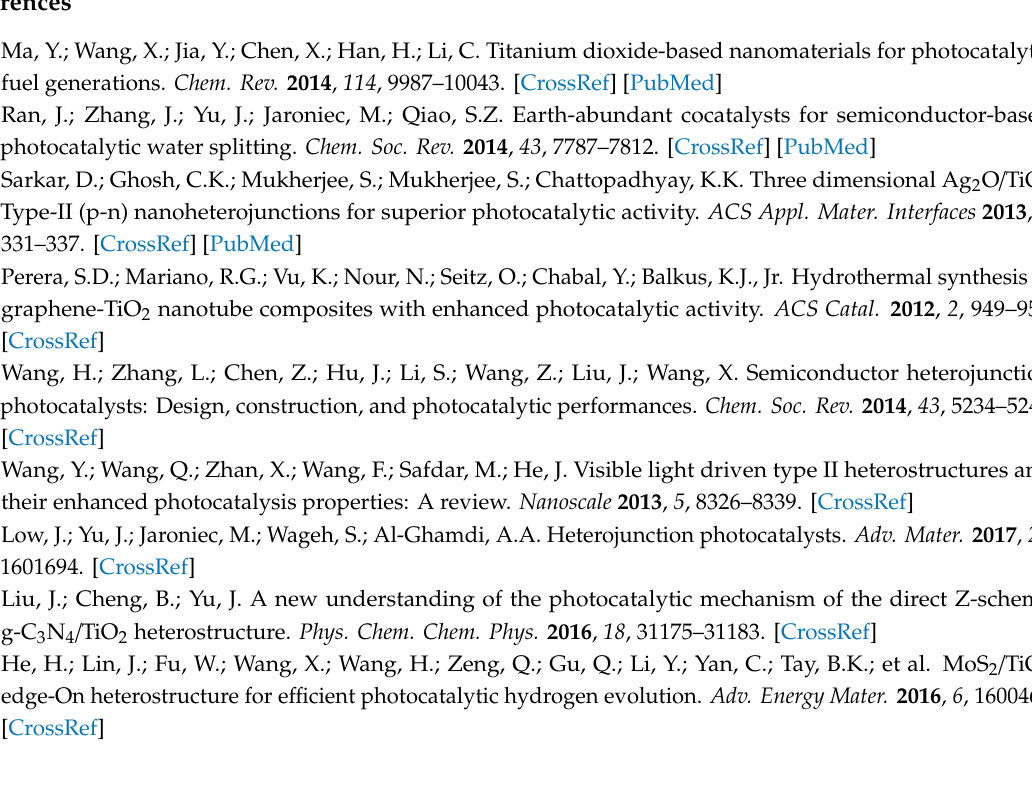
Figure S1 (a-d) EDS spectra of TA1, TA2, TA4, and TA8 samples, respectively. Figure S2 (a-f) XPS survey spectra of T, A, TA1, TA2, TA4, and TA8 samples, respectively. Figure S3 The high resolution XPS core-level binding energy spectra of samples. (a) Ti 2p spectra of T sample; (b-c) Ag 3d and V 2p spectra of A sample; (d-o)Ti 2p, Ag 3d, V 2p spectra of (d-f) TA1, (g-i) TA2, (j-l) TA4, and (m-o) TA8 samples,